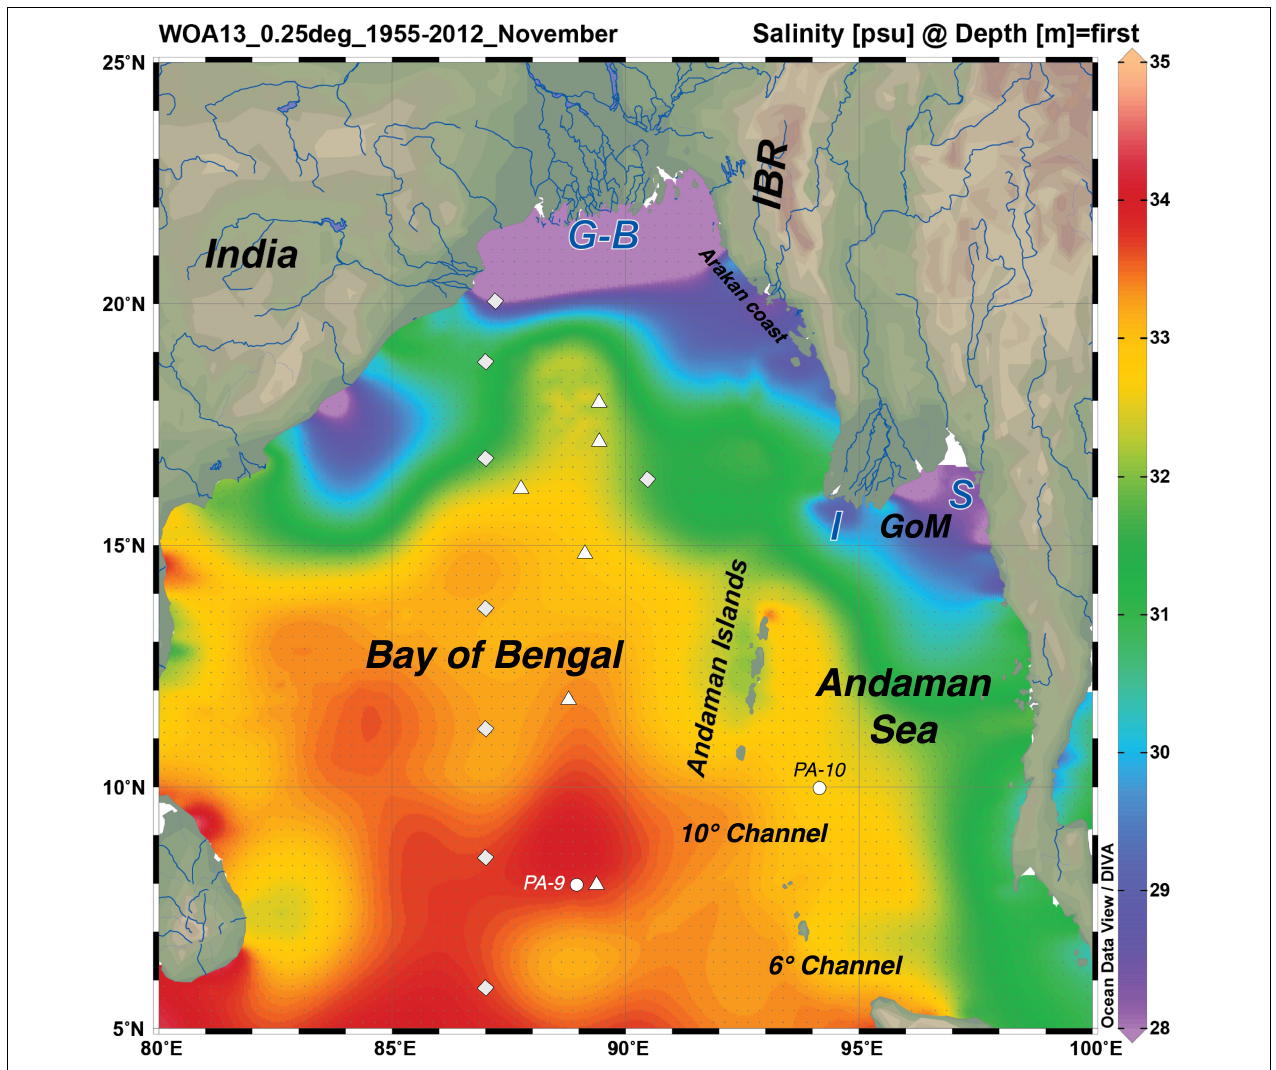
FIGURE 1 | Regional map of the Bay of Bengal (BoB) and Andaman Sea (AnS) showing the mouths of the big four rivers: Ganga and Brahmaputra (G-B), Irrawaddy or Ayeyarwady (I) and Salween (S), the Andaman Islands, and the WOA2013 sea surface salinity climatology for November (1955–2012). This figure was made using Ocean Data View (Schlitzer, R., Ocean Data View, http://odv.awi.de, 2016). Other features of interest are marked: Indo-Burmese Ranges (IBR), Gulf of Martaban (GoM), and the two deep channels connecting the BoB and the AnS. The sampling stations from the other studies of seawater Nd isotopes and rare earth